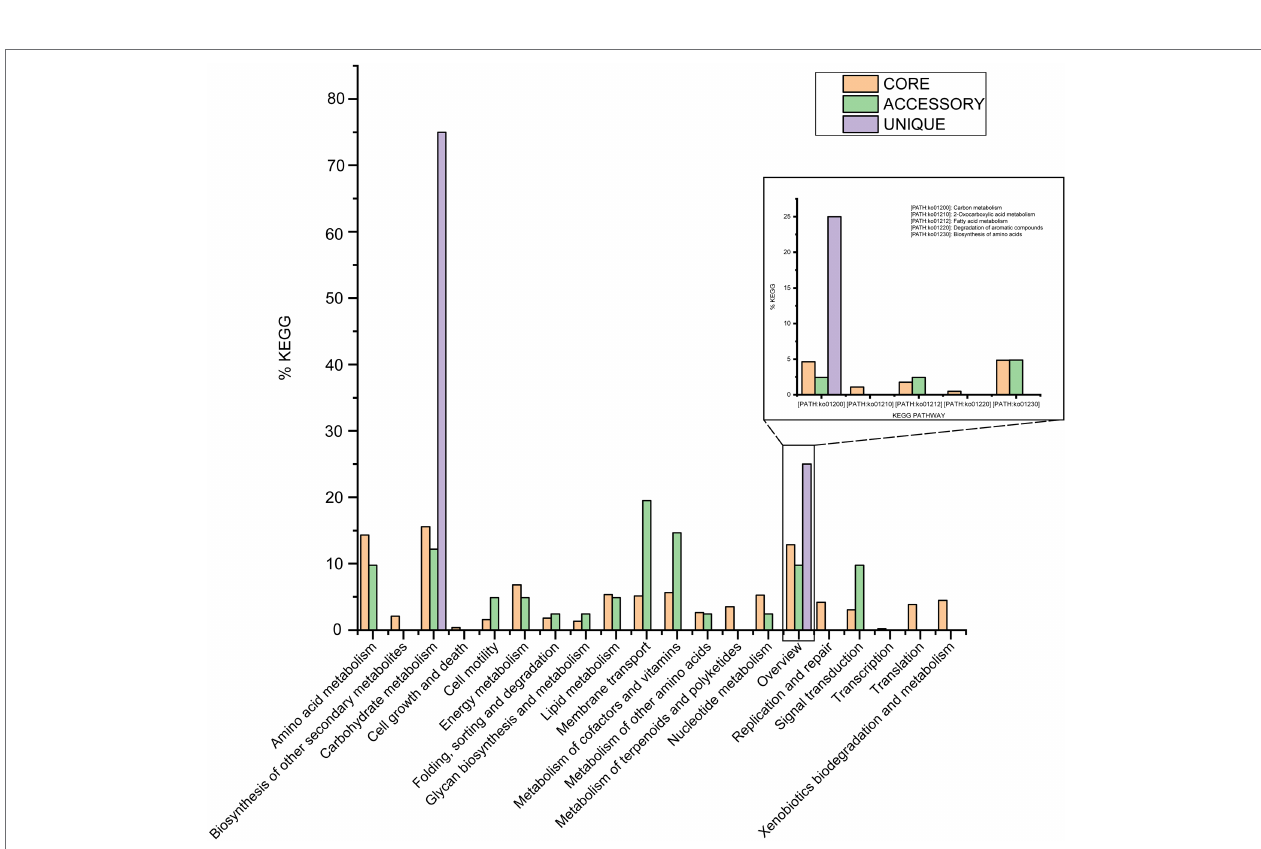
FIGURE 4 | The assigned metabolic pathways associated with the core, accessory, and unique genes among the species Modestobacter deserti from the KEGG database.